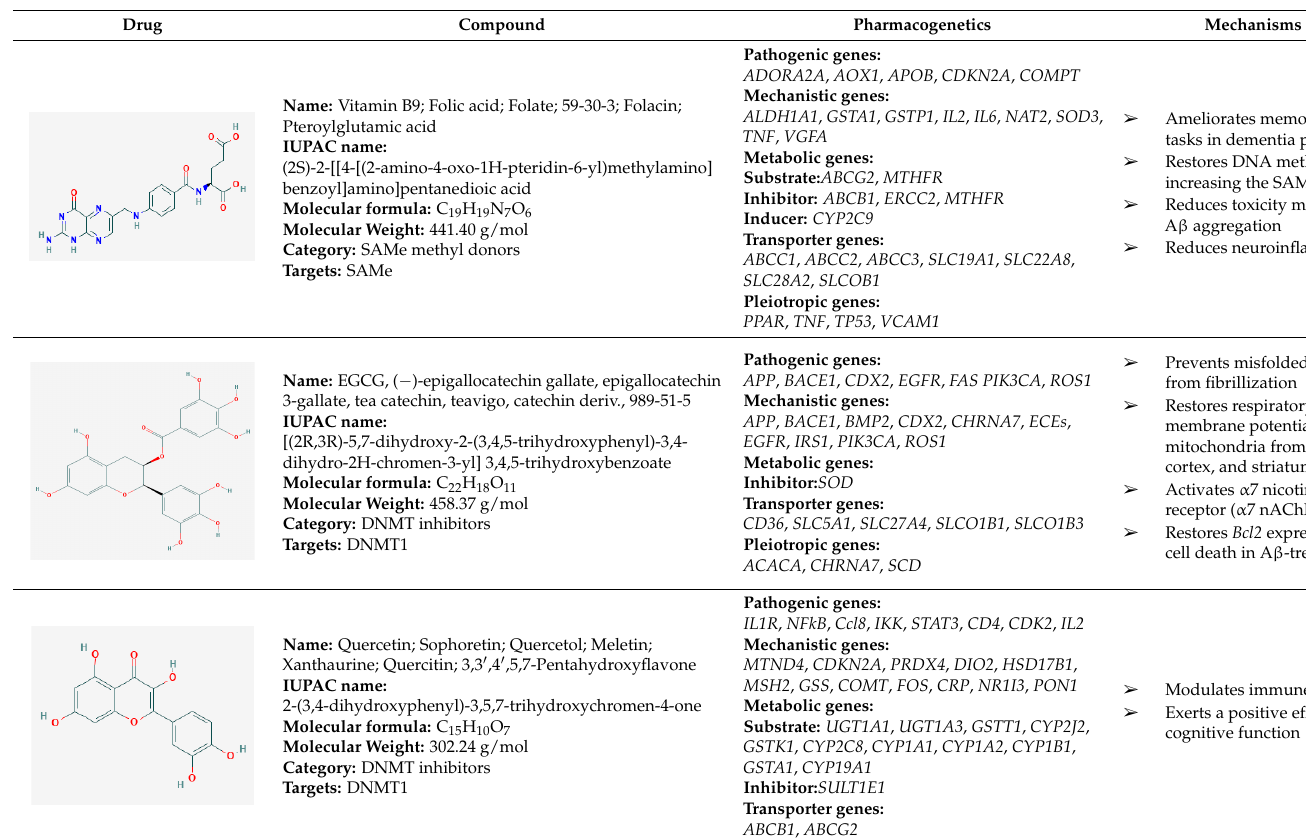
Molecular formula: C 15 H 10 O 7 Molecular Weight: 302.24 g/mol